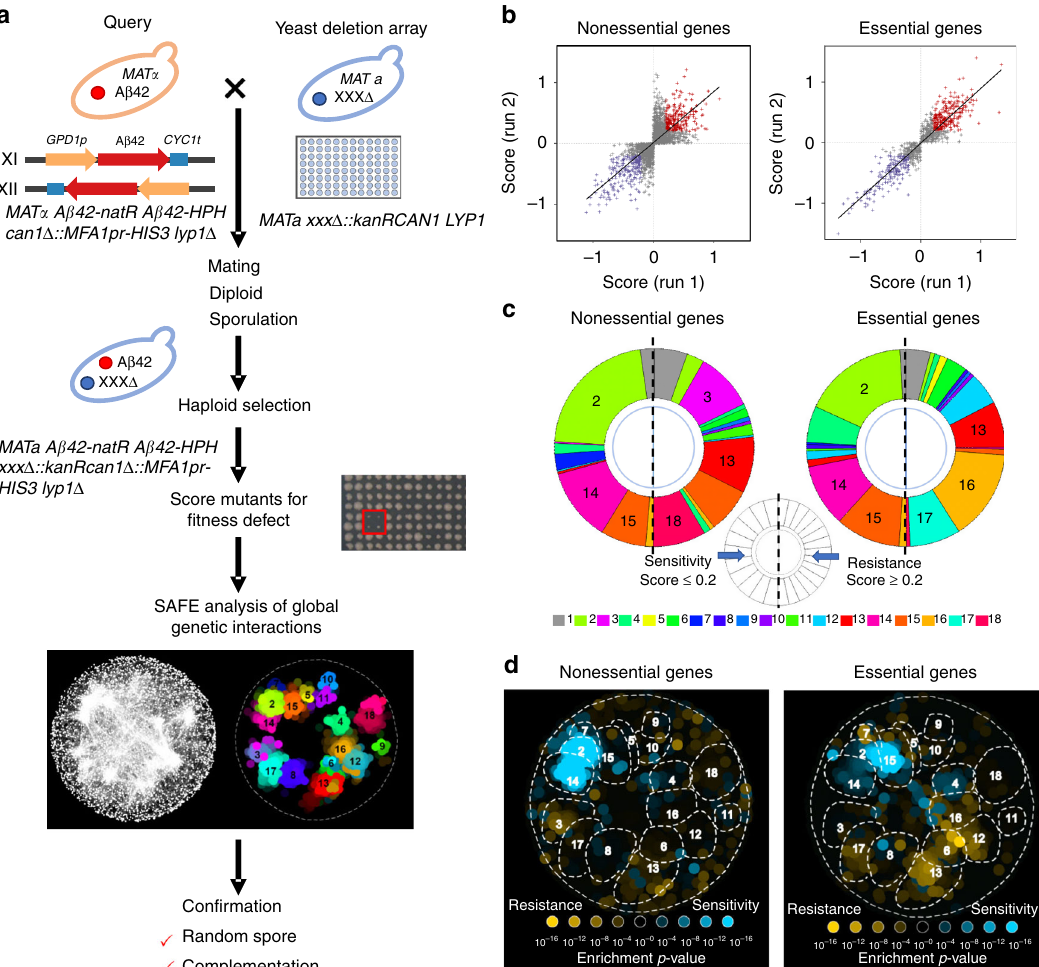
Fig. 1 Genome-wide synthetic genetic array (SGA) screen to identify modulators of A β 42 toxicity. a A schematic work fl ow for identifying mutants that can alter A β 42 toxicity. b Scores for each genetic mutant, from two independent experiments, with those that signi fi cantly change A β 42 toxicity indicated in red ( p -adj < 0.05, score ≥ 0.2), and blue ( p -adj < 0.05, score ≤ − 0.2), respectively. c Gene ontology (GO) biological process term distributions among mutant strains with signi fi cantly affected A β 42 toxicity ( p -adj < 0.05, score ≥ 0.2 or ≤ − 0.2). Each number corresponds to a different biological process GO term as follows: 1. Other; 2. Glycosylation, protein folding/targeting, cell wall biosynthesis; 3. Ribosome biogenesis; 4. Protein degradation; 5. Cytokinesis; 6. Nuclear-cytoplasmic transport; 7. Multivesicular body (MVB) sorting and pH-dependent signaling; 8. mRNA processing; 9. tRNA wobble modi fi cation; 10. Peroxisome; 11. Metabolism and fatty acid biosynthesis; 12. DNA replication and repair; 13. Transcription and chromatin organization; 14. Vesicle traf fi c; 15. Cell polarity and morphogenesis; 16. Mitosis and chromosome segregation; 17. rRNA and ncRNA processing; 18. Respiration, oxidative phosphorylation, mitochondrial targeting. The top 3 GO terms are indicated as number in each individual category. d Spatial analysis of functional enrichment of mutants with signi fi cantly ( p -adj < 0.05) affected A β 42 toxicity and score ≥ 0.2 or ≤ − 0.2. Blue colored points indicate mutants more sensitive to A β 42 toxicity (score ≤ − 0.2) and yellow color indicates mutants that are more resistant (score ≥ 0.2), as measured via their growth during SGA screening. GO biological process terms are indicated as in c and outlined by dashed